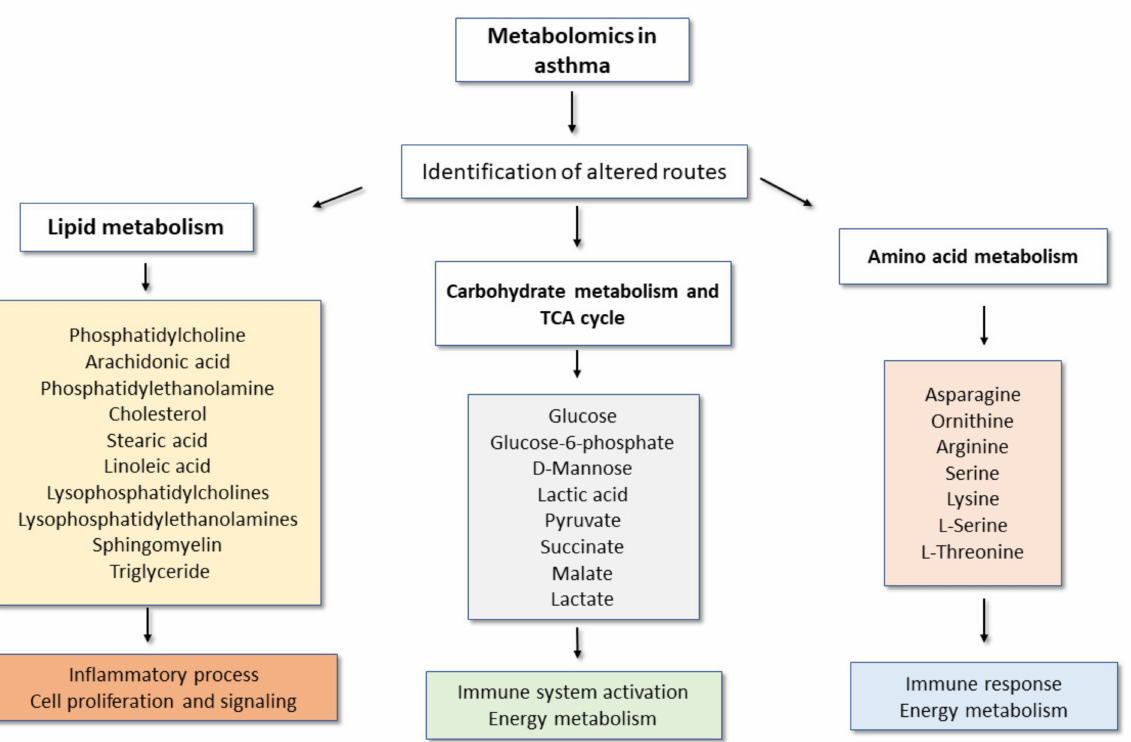
Figure 2. Representation of the main altered metabolic pathways and the main metabolites observed in studies of targeted and non-targeted metabolomics, as well as their relationship with some general implications for asthma. The left-hand side of the figure includes the most important pathway (lipid metabolism) and some of its metabolites, also demonstrating how these metabolites have implications for inflammatory processes, cell proliferation and signaling. In the centre, some metabolites of carbohydrate metabolism and citric acid cycle (TCA) are shown. These have been shown to have implications for activating the immune system and generating energy. On the right-hand side, some metabolites of the altered amino acid pathway are identified. These are involved in the immune response and energy